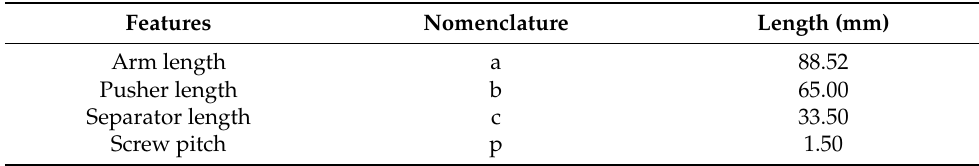
Table 2. Main design features for the proposed heliostatic illuminator.